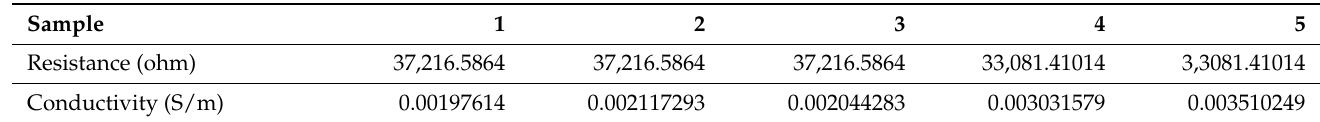
Table A11. Conductivity Data for Nylon 610 Nanocomposites with 0.5 wt% Graphite Nanosheets Treated at 150 ◦ C and − 1 bar.